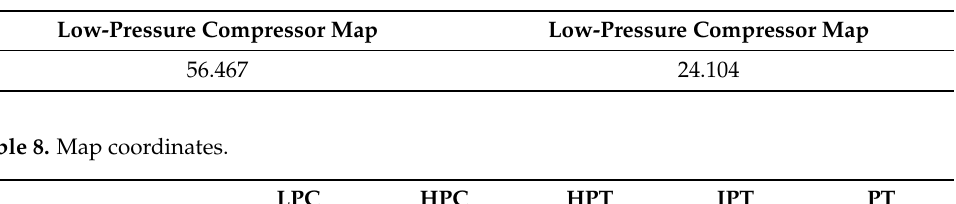
Table 7. Surge margin [%].